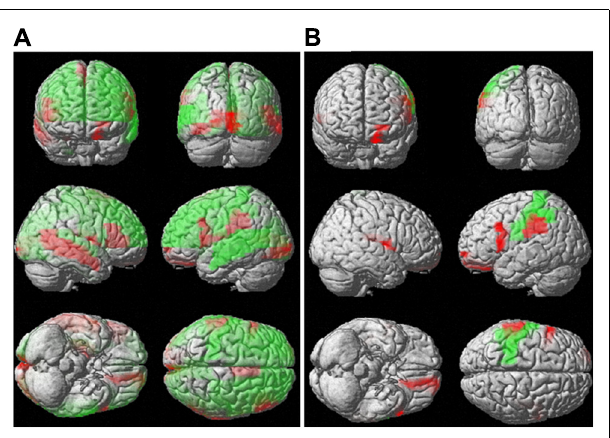
FIGURE 6 | Regions of interest with significant correlations in male mean diffusivity and in diffusion kurtosis. This figure is a scatter plot for the age where the correlation is significant ( p < 0.001) [ (A) mean diffusivity in